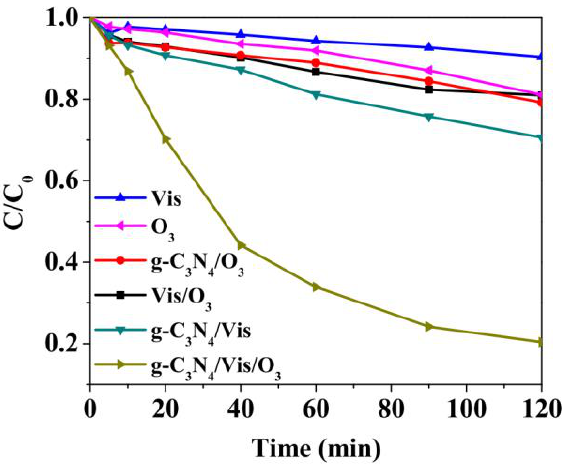
Figure 7. Degradation of OA by different photocatalytic processes. Reproduced with permission from ref. [58]. Copyright 2014 Elsevier.